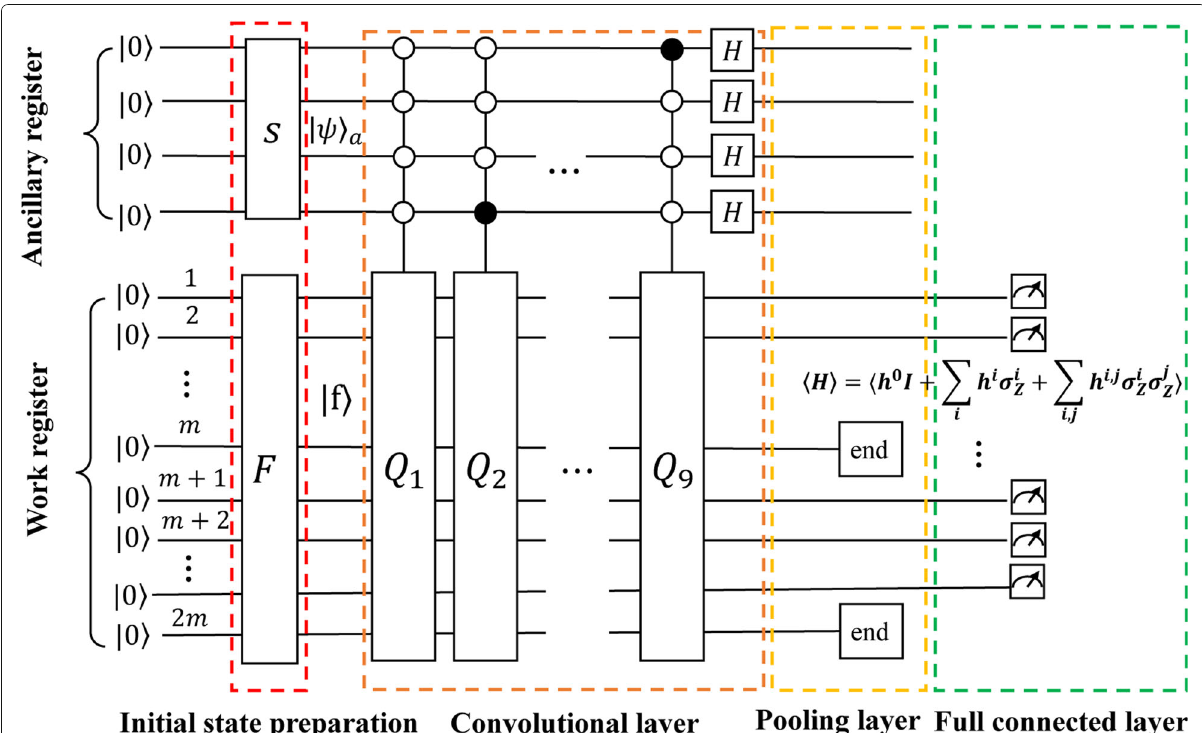
Fig. 2 Quantum circuit for realizing the QCNN. | f (cid:3) denotes the initial state of work system after encoded the image data, and the ancillary system is a four qubits system in the | 0000 (cid:3) a state. The squares represent unitary operations and the circles represent the state of the controlling system. Unitary operations Q 1 , Q 2 , ··· , Q 9 , are activated only when the auxiliary system is in state | 0000 (cid:3) , | 0001 (cid:3)··· , | 1000 (cid:3)